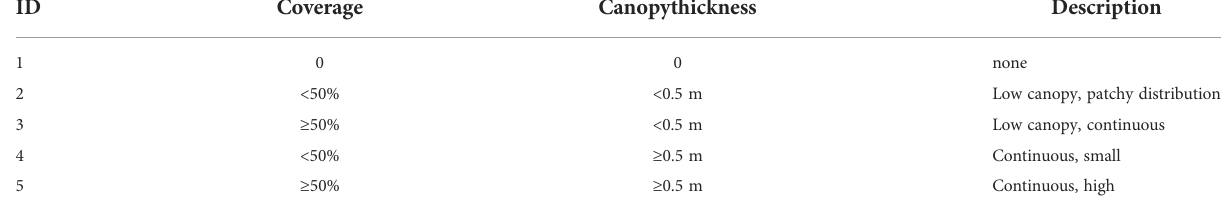
TABLE 1 Description of canopy categories in the current